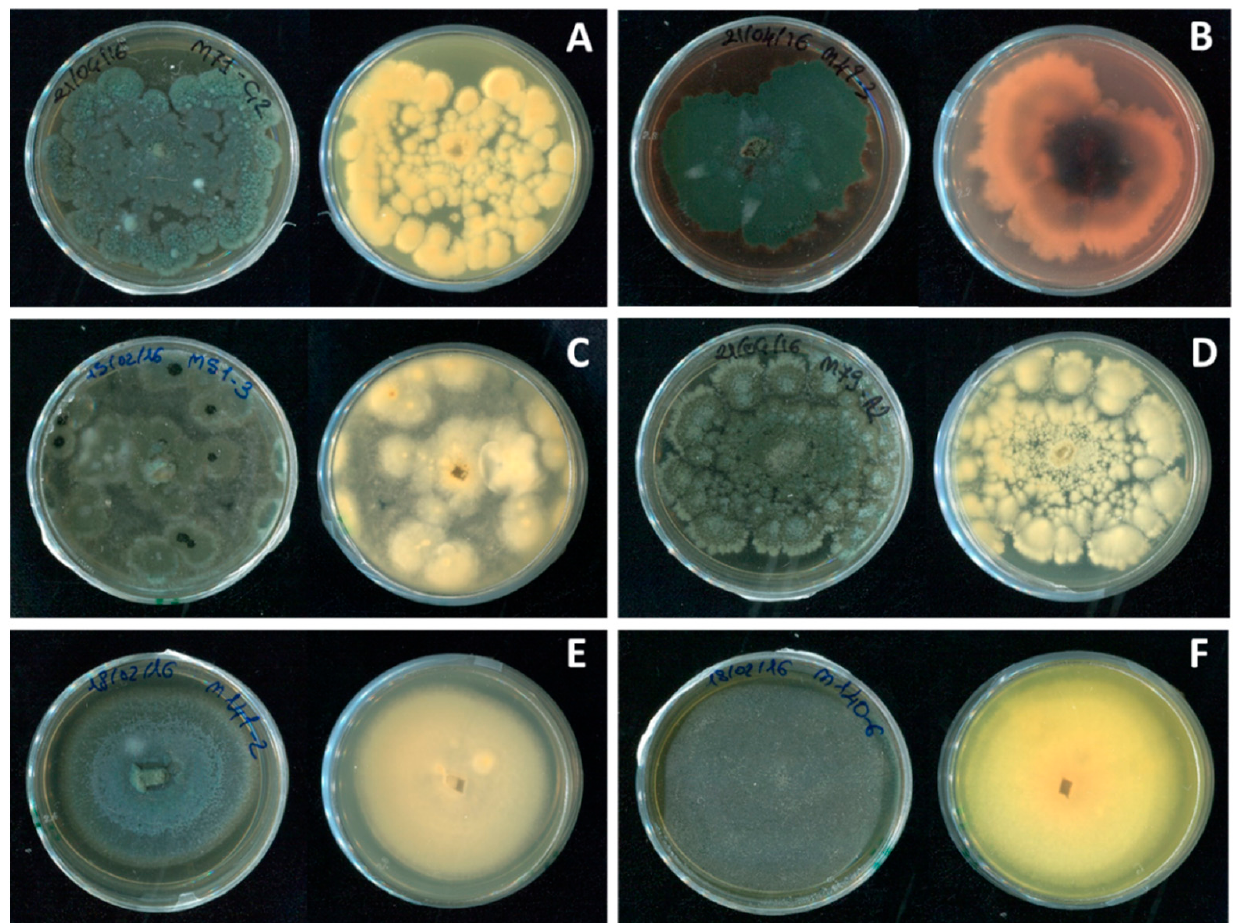
Figure 3. Talaromyces albobivertillius on MEA plate: front ( left ) and reverse ( right ); significant is the production of red exudates.